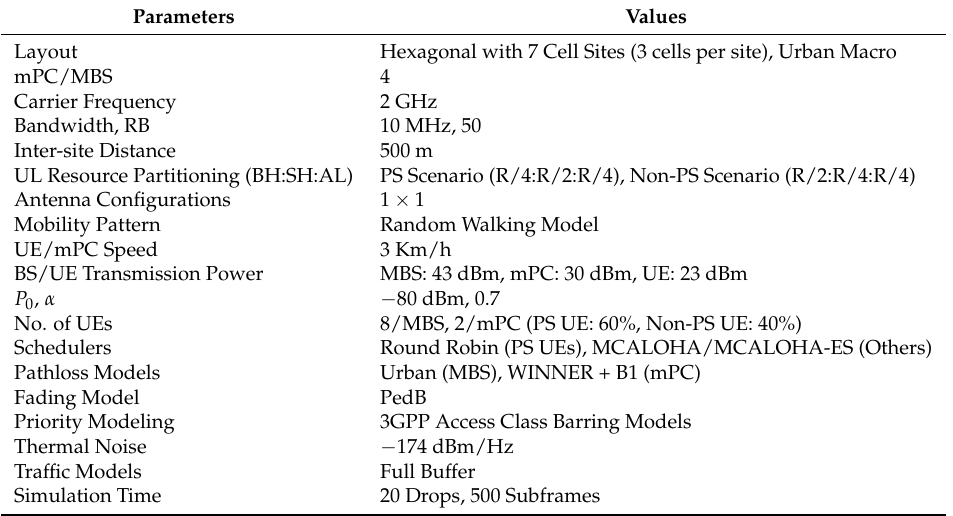
Table 3. Simulation